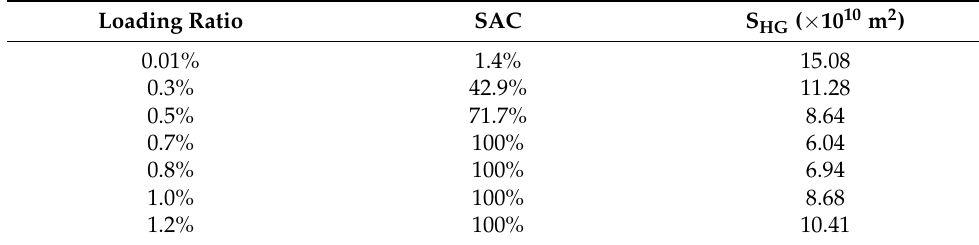
Table 4. SAC of host particle covered by additives.